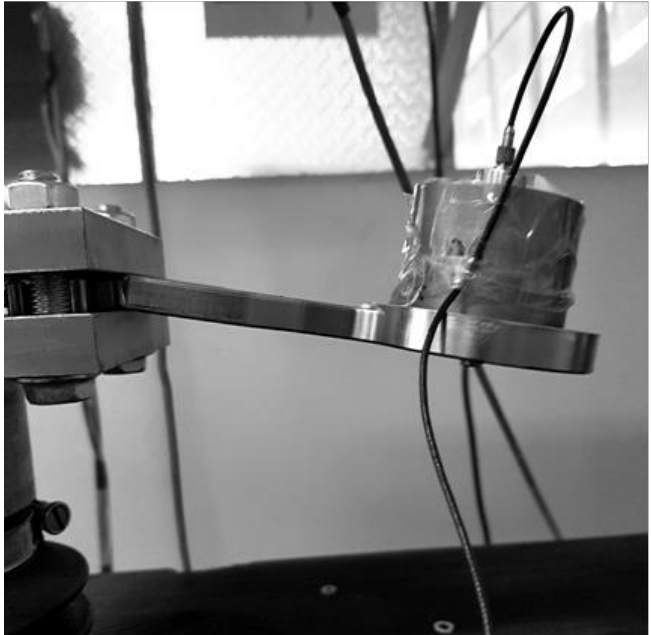
Figure 20. The tested device with 0.620 kg additional mass at breaking moment.